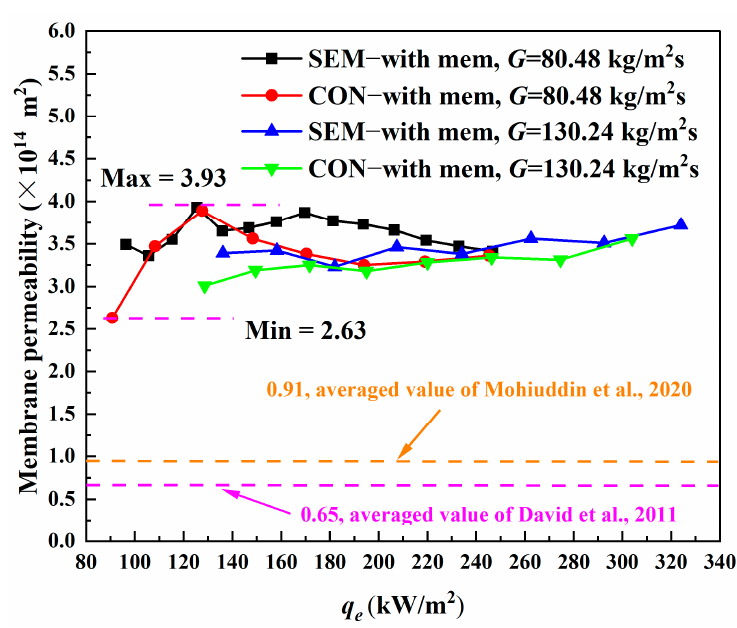
Figure 16. Comparison of membrane permeability with the value reported in the literature [24,25,27].